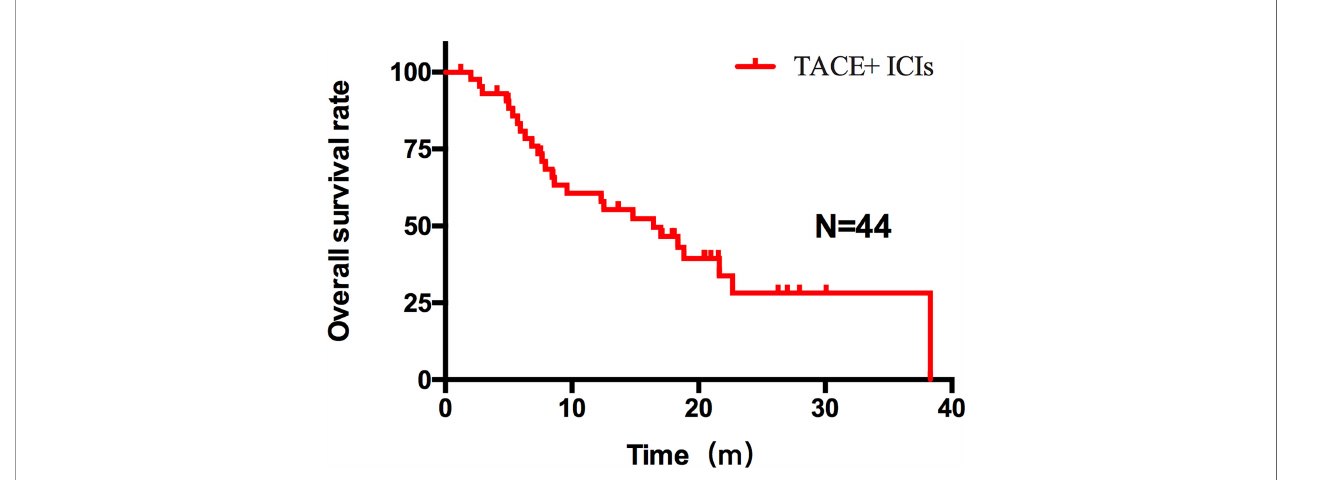
FIGURE 2 | OS of all patients after TACE – ICIs combined therapy. Patients after TACE-ICIs combined therapy achieved a median OS of 16.43